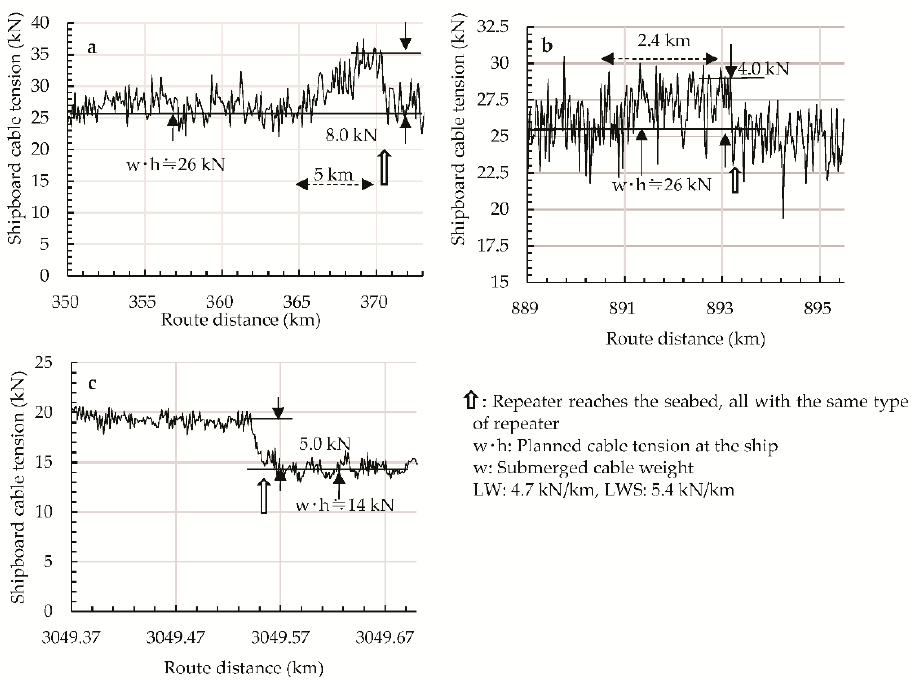
Figure 23. Change in measured shipboard cable tension when the repeater reaches the seabed in various laying conditions.